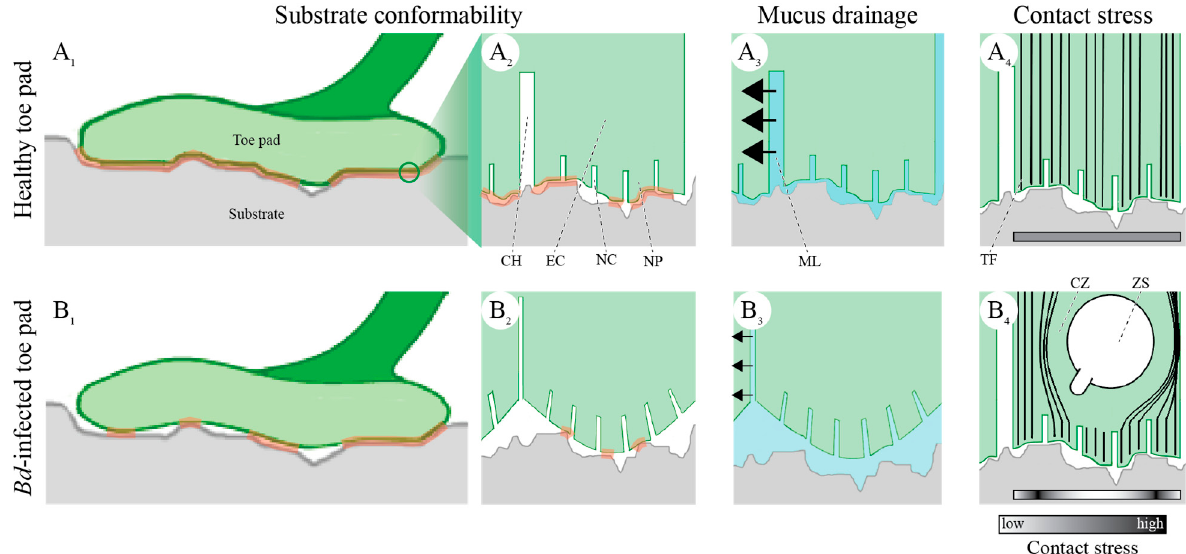
Figure 3. Schematic depiction of ( A ) some of the attachment mechanisms embodied in the healthy epidermis of tree frog toe pads, and ( B ) the hypothesized disruptions of these mechanisms upon Bd infection. ( A 1,2 ) The softness of healthy toe pads and the hierarchical pillar-channel pattern on the pad surface facilitate the formation of a large area of close contact (red) on macrorough and micro- to nanorough substrates, respectively. ( A 3 ) The interconnected network of channels in between epidermal cells and nanopillars enables effective drainage of mucus and other interstitial liquids (large arrows), thus supporting the formation of close contact. ( A 4 ) An intact tonofilament network possibly ensures an approximately uniform distribution of contact stresses across the contact surface. ( B 1 ) Hyperkeratosis and hyperplasia may stiffen the toe pad and reduce conformability to macrorough substrates. ( B 2 ) Convex bulging of epidermal cells could hamper close contact formation to (sub-)microscopically rough substrates. ( B 3 ) Narrowed channels result in less effective mucus drainage (small arrows) and disable close contact formation. ( B 4 ) Rearrangement of tonofilaments around zoosporangia disrupts a uniform contact stress distribution and may increase local stress maxima. CH, channel between epidermal cells; CZ, clear zone surrounded by rearranged tonofilaments; EC, epidermal cell; ML, mucus layer; NC, channel between nanopillars; NP, nanopillars; TF, tonofilaments; ZS, zoospore.